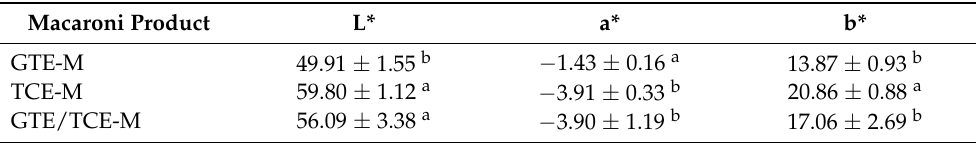
Table 3. Physical properties of cooked GTE-M, TCE-M and GTE/TCE-M products. Data obtained from triplicate experiments are expressed as mean ± SD values. Within the same column, values presented with different superscript letters ( a,b ) are significantly different ( p < 0.05) from each other. Macaroni Product